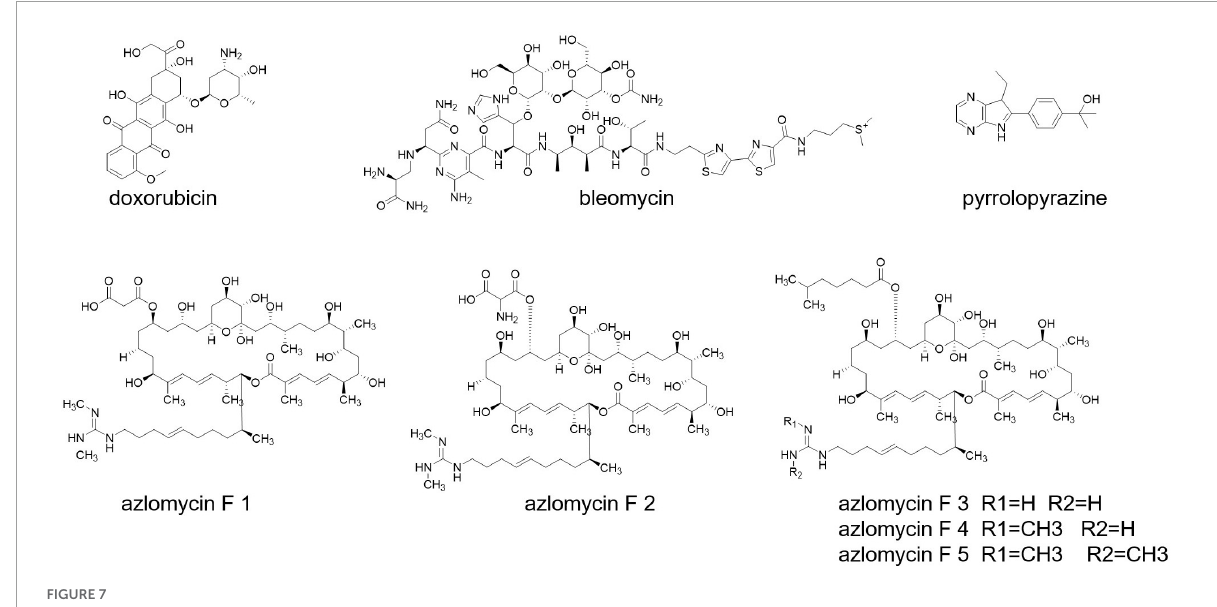
FIGURE7 Anti-cancer drugs from Streptomyces .